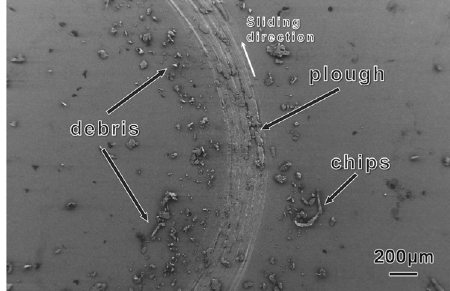
Figure 5 SEM micrographs of pin-on-disk worn surface on